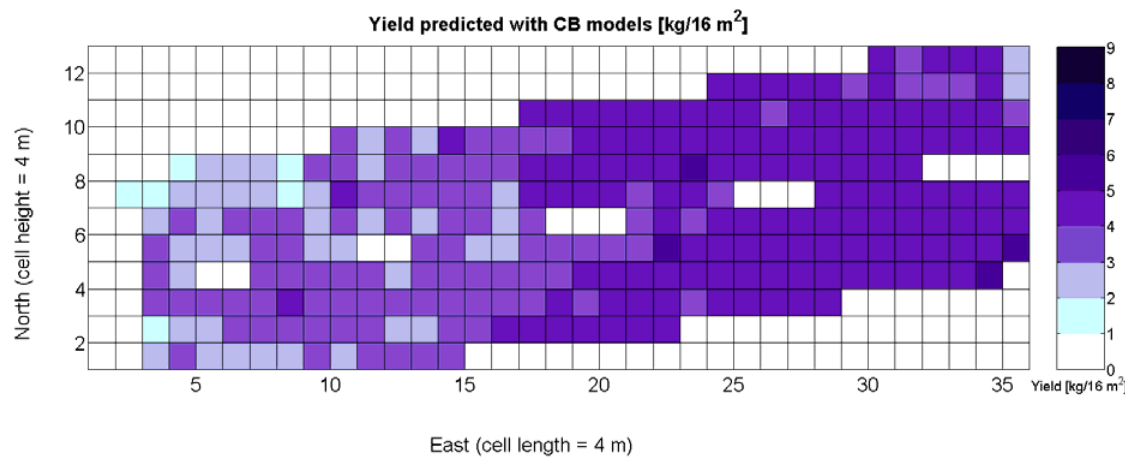
Figure 34. Yield predicted with CB models for high resolution maps.